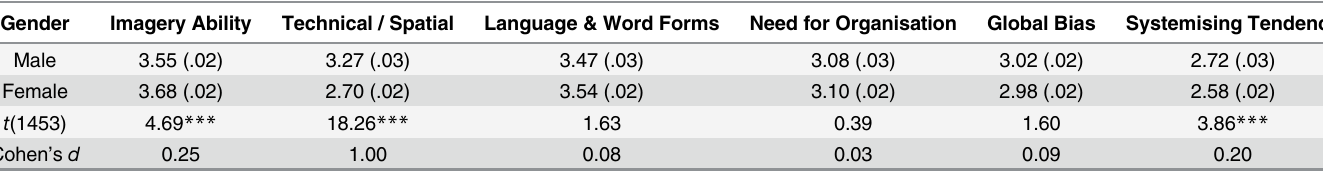
Table 3. Mean factor scores as a function of